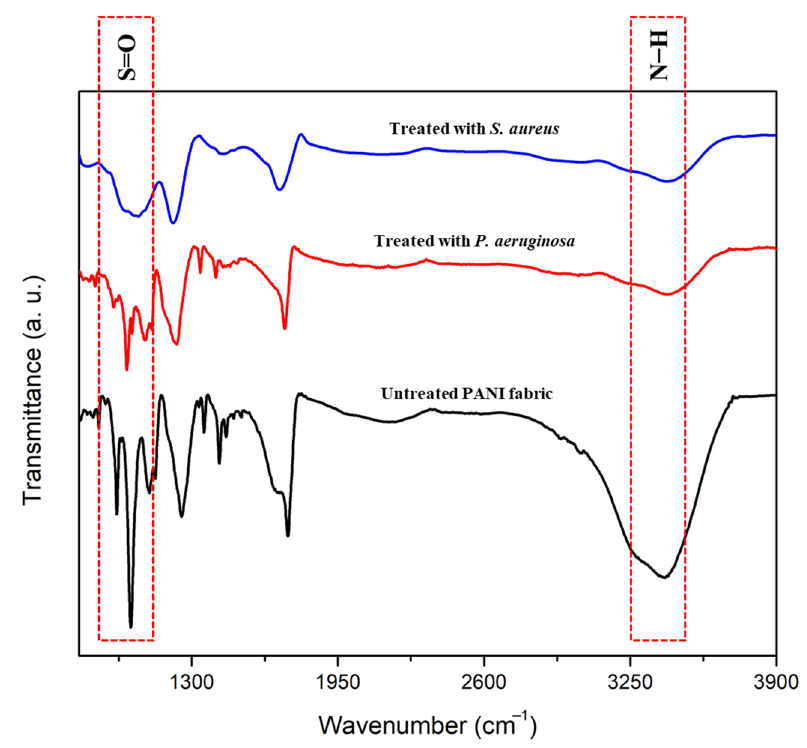
Figure 7. FTIR spectra of untreated PANI fabric, and of PANI fabric treated with S. aureus and P. aeruginosa .